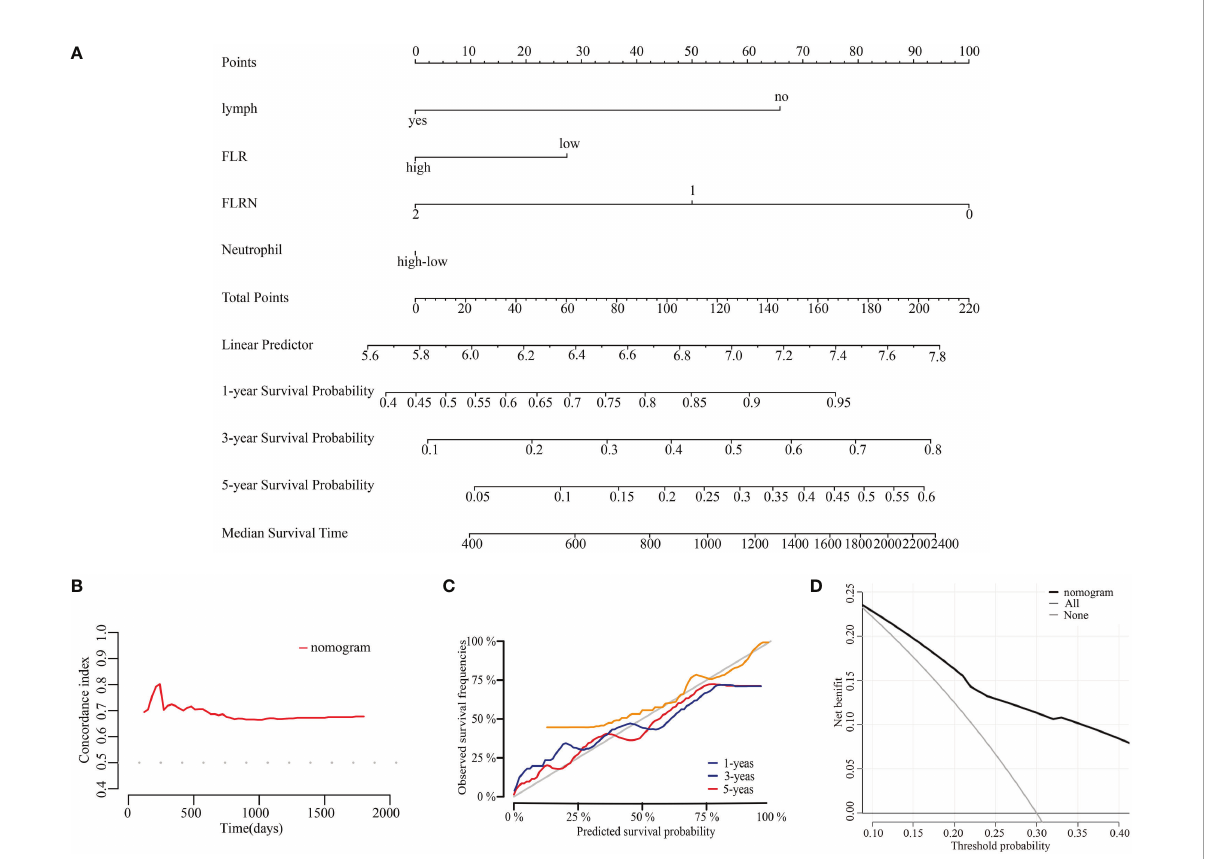
FIGURE 5 Construction and evaluation of prognostic nomogram. (A) Nomogram for prognosis of ECC. (B) C-index curves of the model at different times. (C) Calibration curves of the model at different times. (D) DCA curves of the